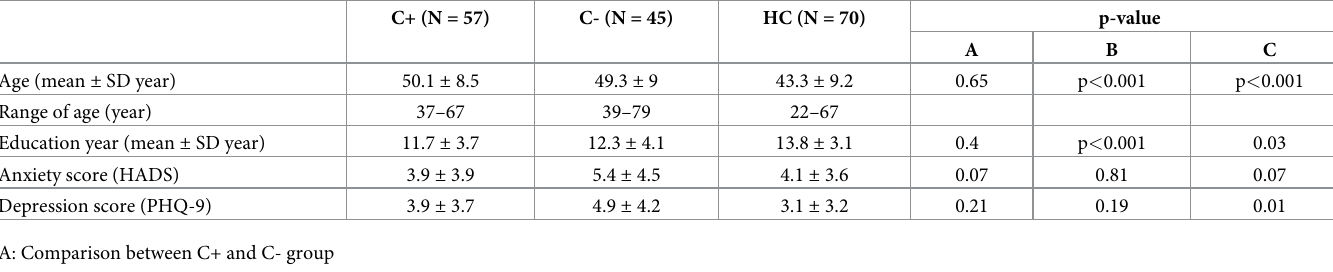
Table 1. Demographic